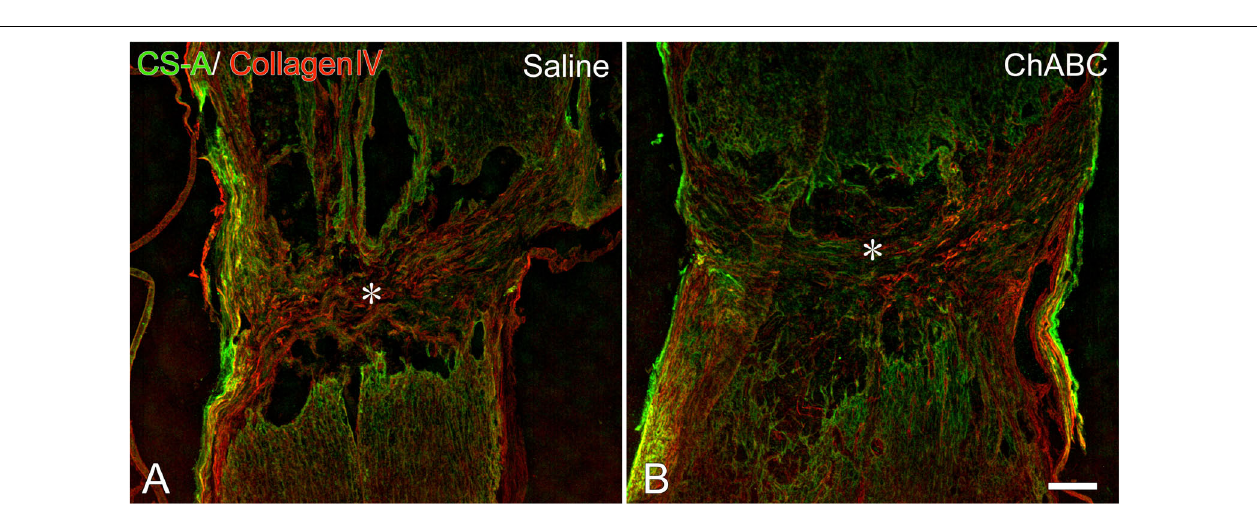
FIGURE 2 | Double-labeled images of immunohistochemistry for collagen IV (red), chondroitin sulfate (CS)-A (green) at the lesion site of rats with saline (A) , and chondroitinase ABC (ChABC) (B) administration at 3 weeks after CST. Asterisks indicate the center of the lesion. Scale bars = 200 µ m.